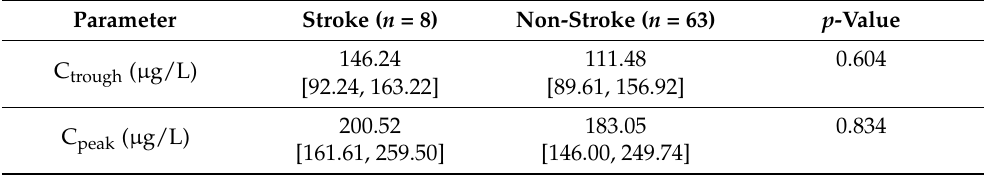
Table 3. The trough and peak values of the apixaban plasma levels classified by stroke